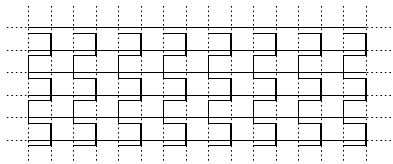
Fig. 1: An EPG representation of a complete bipartite graph in a 16 × 6